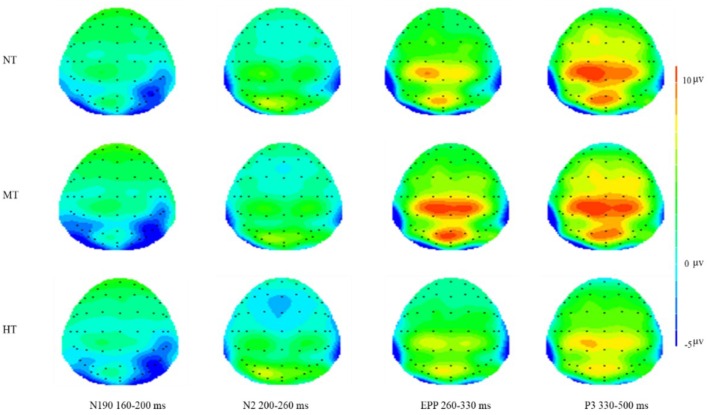
Topographical maps of three conditions on N190, N2, EPP, and P3. Significantly larger frontal N2 amplitude occurred in the HT condition and significant central EPP amplitude occurred in the MT condition.